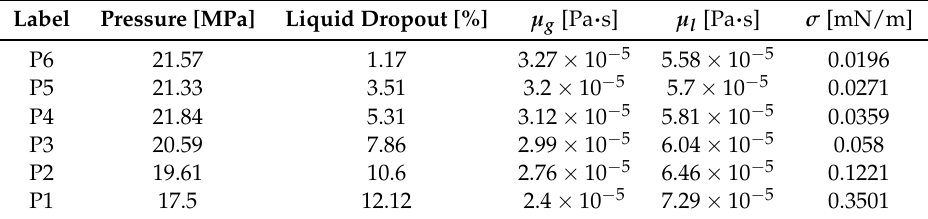
Table 2. Fluid properties at flowing